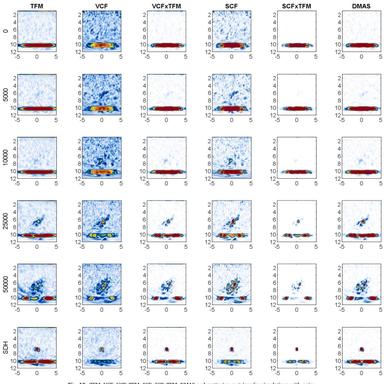
TFM, VCF, VCFxTFM, SCF, SCFxTFM, DMAS and scattering matrices for simulations with noise.